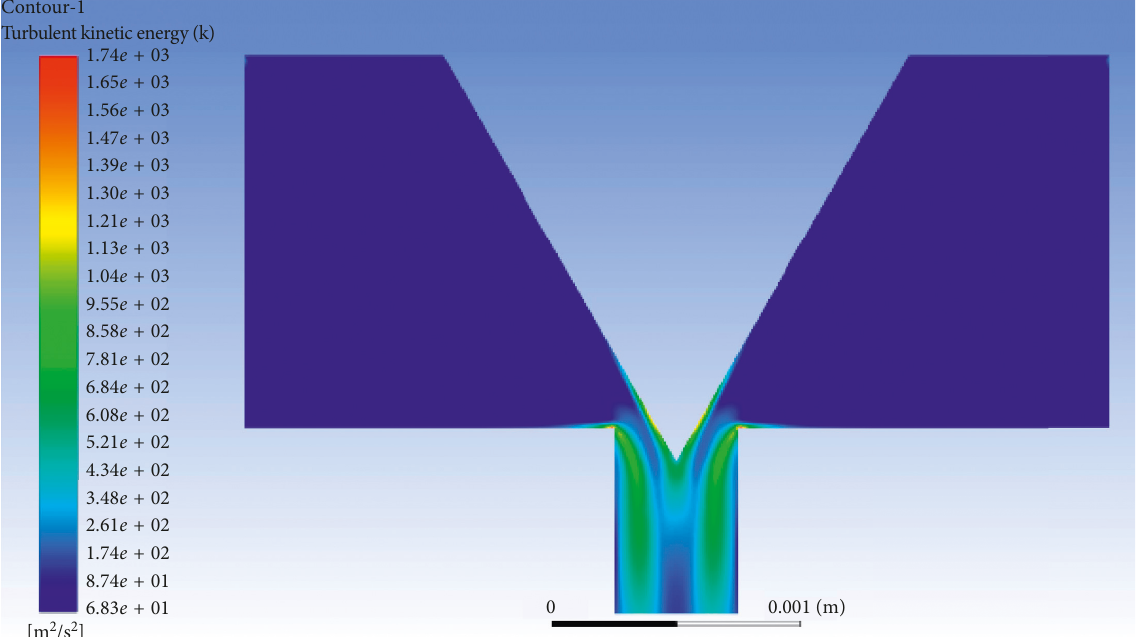
Figure 31: Turbulent kinetic energy distribution nephogram of a poppet valve core angle of 60 °